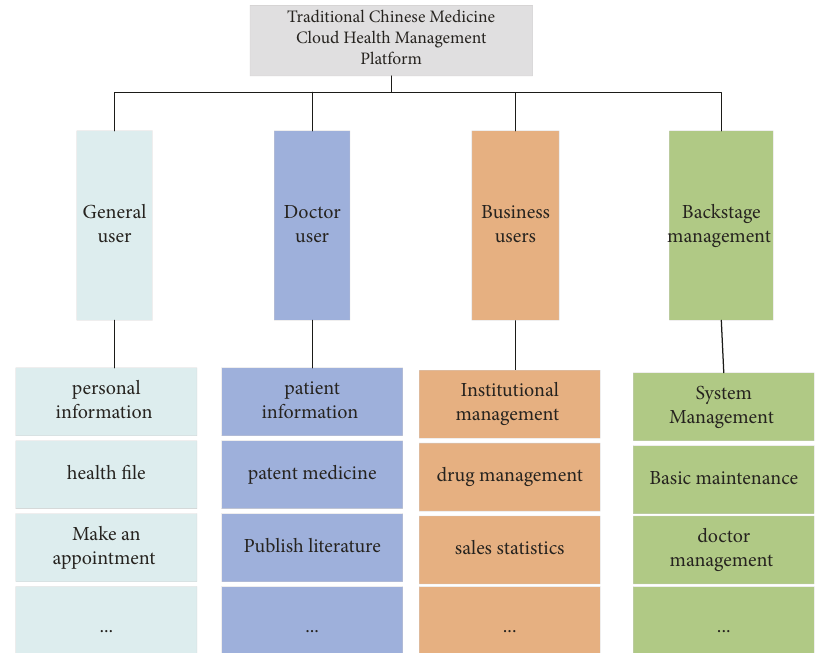
Figure 3: Main functions of TCM cloud health